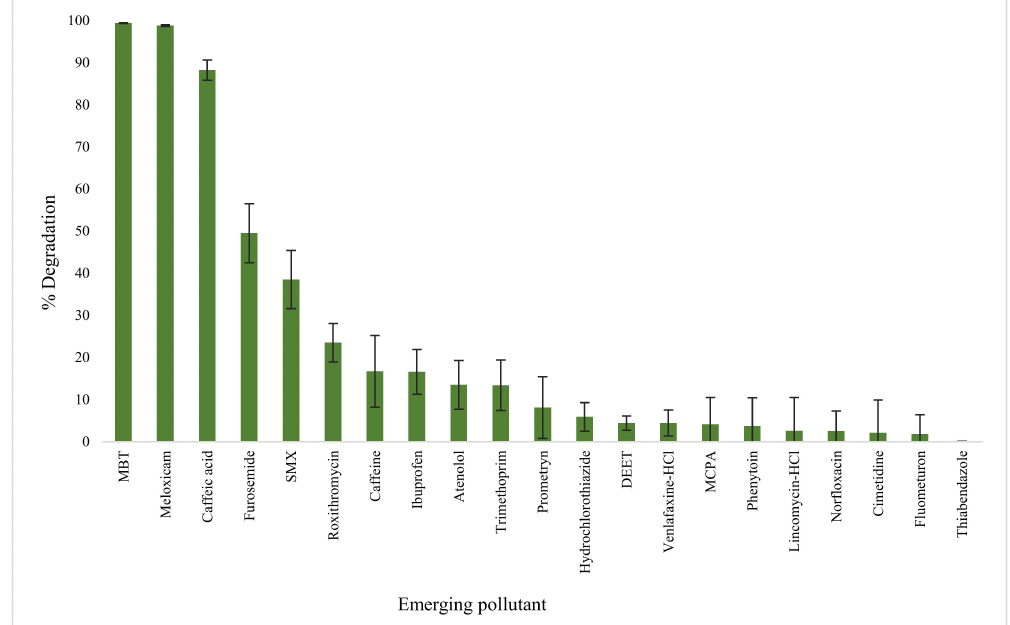
Figure 1. Degradation of 21 emerging pollutants by SBP + H 2 O 2 . [Pollutants] = 2 ppm, [Enzyme] = 0.39 µ M, [H 2 O 2 ] = 0.3 mM (0.1 mM added 3 times of 10 min interval), pH =